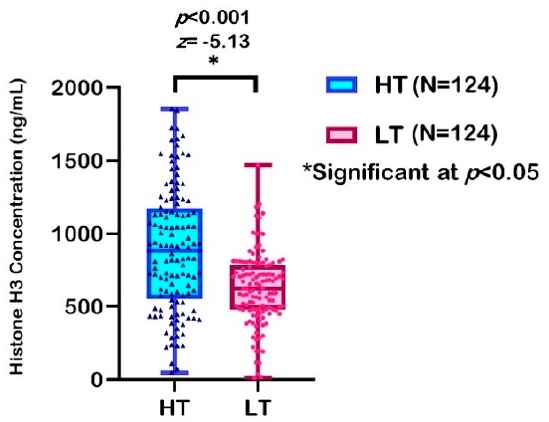
Figure 3. Expression profile of histone H3 modification between two groups of respondents.